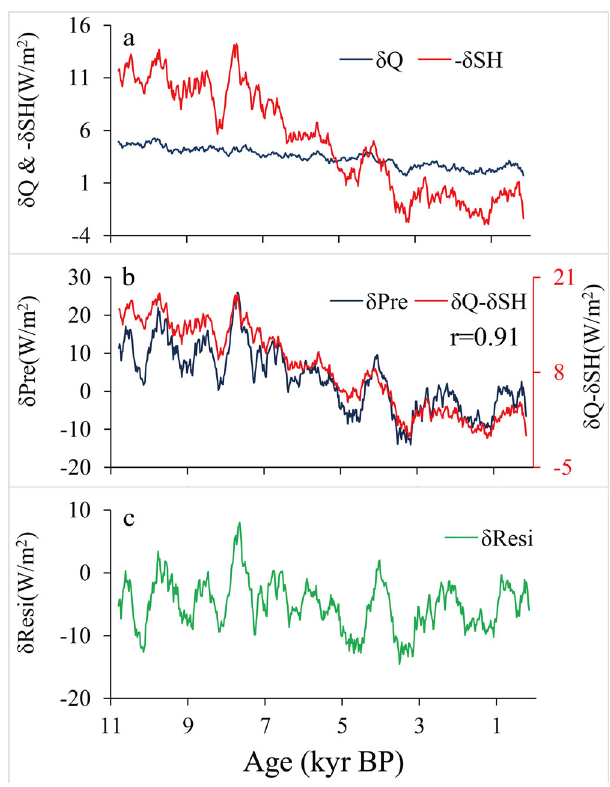
Fig. 4 Variations of each component in the energy balance equation related to precipitation in the Holocene. a Differences between DV and nDV for non-adiabatic cooling ( δ Q) and negative surface sensible heat fl ux ( − δ SH); b same as a but for precipitation ( δ pre) and δ Q − δ SH; c same as a but for residual items ( δ